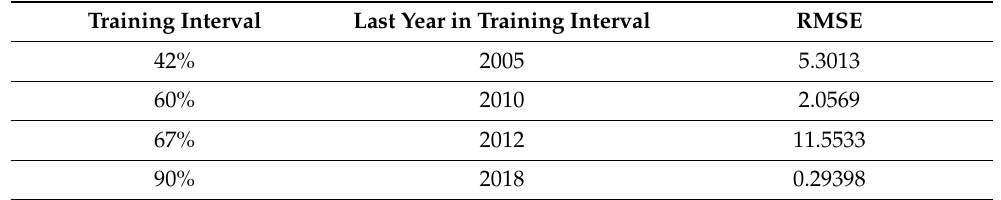
Table 1. RMSE for predicted data.